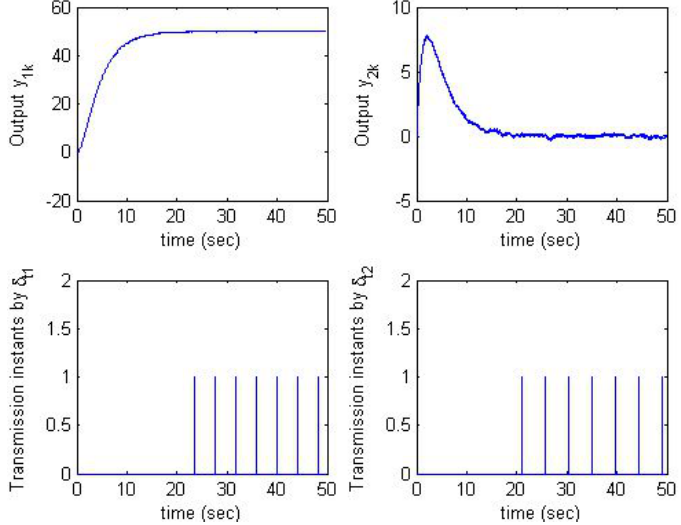
Figure 8. Instants the sensor node transmits data due to condition